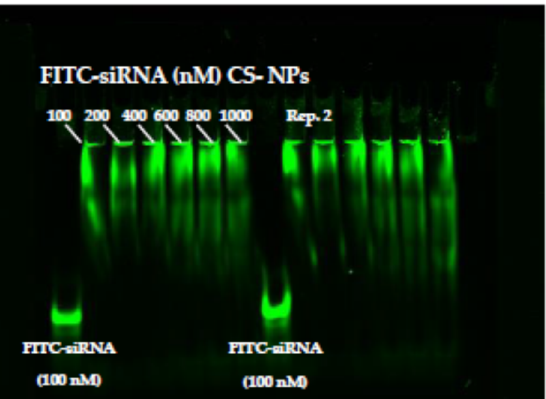
Figure 2. Polyacrylamide gel electrophoresis behavior of FITC siRNA and FITC siRNA loaded on CS-NPs at different concentrations from 100 to 1000 nM. Rep 2 indicates a second replicate of the same experiment.